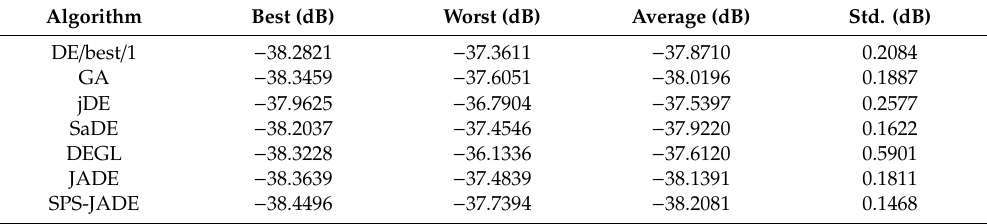
Table 1. Synthesis results of the normalized MSLs for the linear antenna array with sidelobe